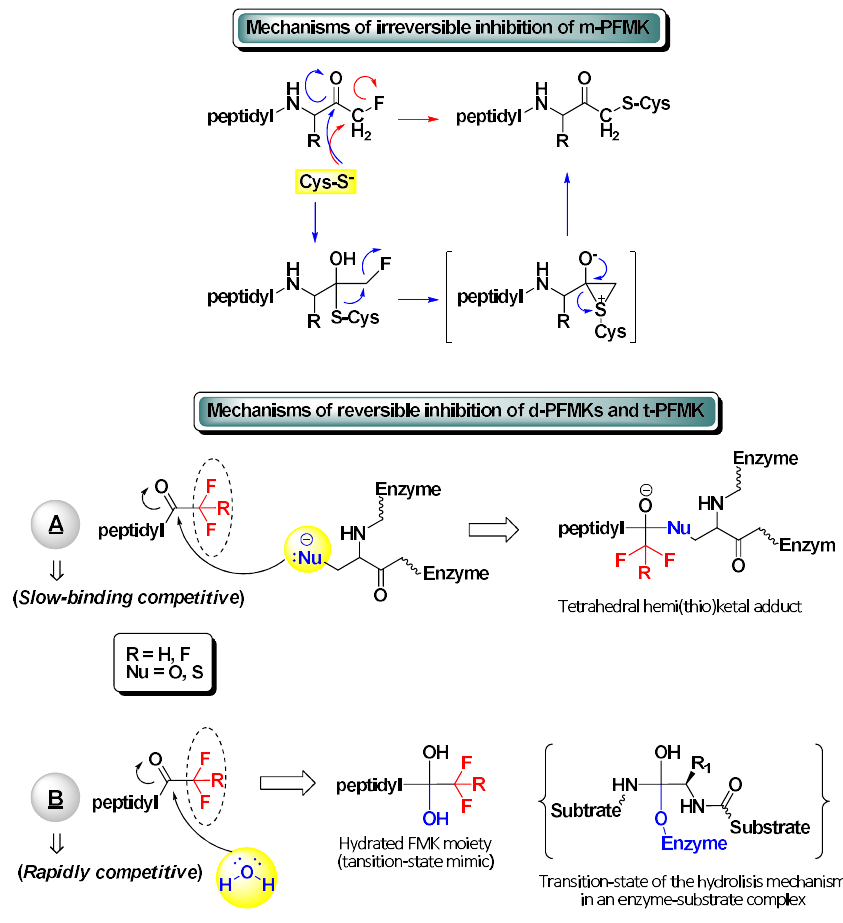
Figure 1. Schematic representation of the possible inhibitory mechanisms of action of all types of peptidyl fluoromethyl ketones (PFMKs).